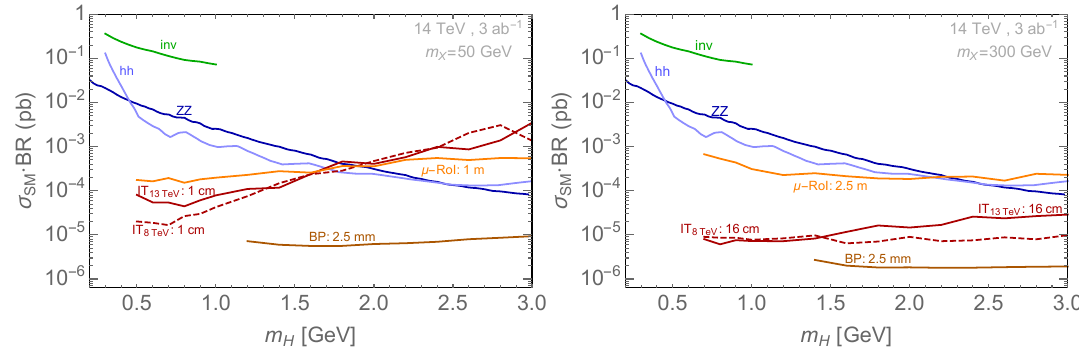
Figure 3 . Projected reach in cross sections times branching ratio at HL-LHC. Dark blue for (cid:30) ! ZZ , dark green for (cid:30) ! inv., light blue for (cid:30) ! hh . These channels are rescaled by p L HL-LHC =L 13TeV . For (cid:30) ! XX we consider X ! jj with di(cid:11)erent values of the X lifetimes and left and right panels correspond to m X = 50 GeV and m X = 300 GeV. For these channels, we rescale the results in (cid:12)gure 1 with L HL-LHC =L 13TeV . Orange is the ATLAS (cid:22) -RoI exclusion with c(cid:28) X (cid:24) m [32], dark red is the CMS IT exclusions at 13 TeV c(cid:28) X (cid:24) cm [33], dark red-dashed is the CMS IT exclusion at 8 TeV [35] with the same c(cid:28) X projected with 13 TeV luminosity, and dark orange is the CMS beam pipe search at 13 TeV with c(cid:28) X (cid:24) mm